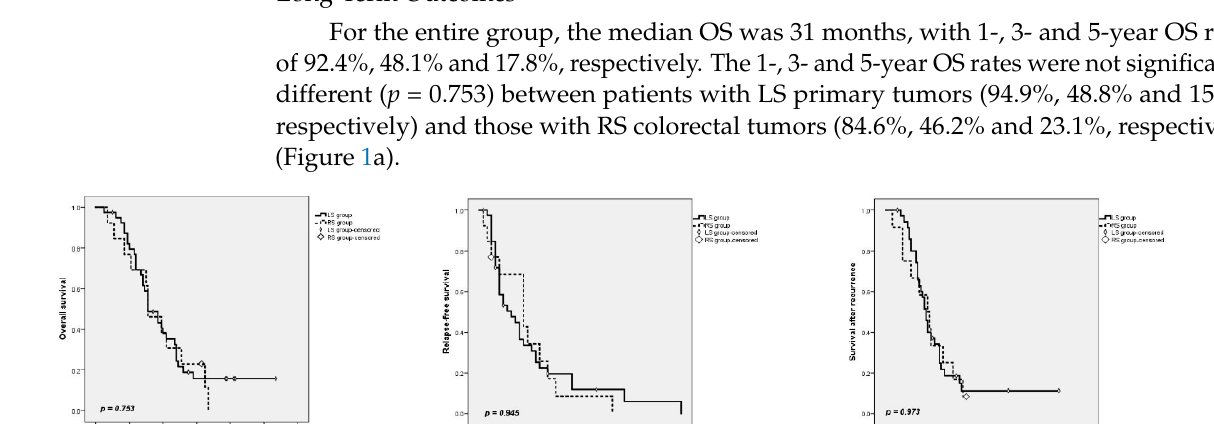
Long-Term Outcomes